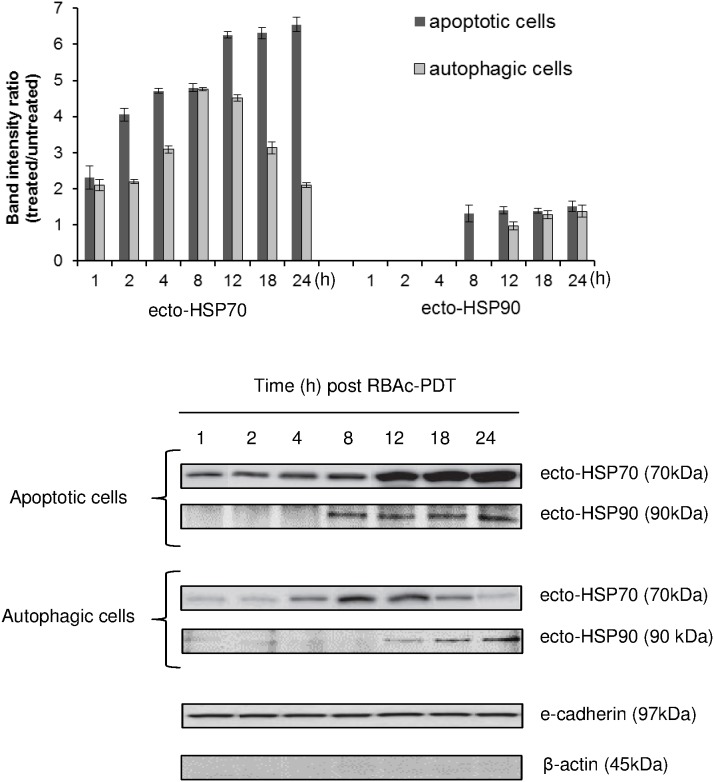
Surface exposure of HSP70 and HSP90 in RBAc-PDT-treated HeLa cells.Kinetic of HSP70 and HSP90 membrane translocation (ecto-HSP70 and ecto-HSP90) was performed by Western blot of electroblotted to nitrocellulose membrane SDS-PAGE of membrane proteins fraction (30 µg protein/lane) of RBAc-PDT treated HeLa cells (10−5 M RBAc, 1 h, 1.6 J/cm2, 90 sec) in the presence of 3-MA (10 mM) and Nec-1 (300 µ) (apoptotic cells) and in the presence of z-VAD-FMK (20 µM) and 3-MA (10 mM) (autophagic cells) at the indicated time intervals. Monoclonal antibodies against HSP70 (70 kDa) and HSP90 (90 kDa) were used. The amount of HSP70 and HSP90 proteins was reported as band intensity ratio (treated/untreated) measured by densitometer analysis. E-cadherin (97 kDa) and β-actin (45 kDa) expression is shown as a control. Actin is absent in the membrane proteins fraction. The data are the mean ± SD of three independent experiments. The values for ecto-HSP70 of the apoptotic cells are always significantly different (p<0.05) with respect to autophagic cells. The values of apoptotic and autophagic cells values are significantly different (p<0.05) with respect to untreated cells for both ecto-HSP70 and ecto-HSP90. One representative Western Blot is shown out of the three independent experiments performed.